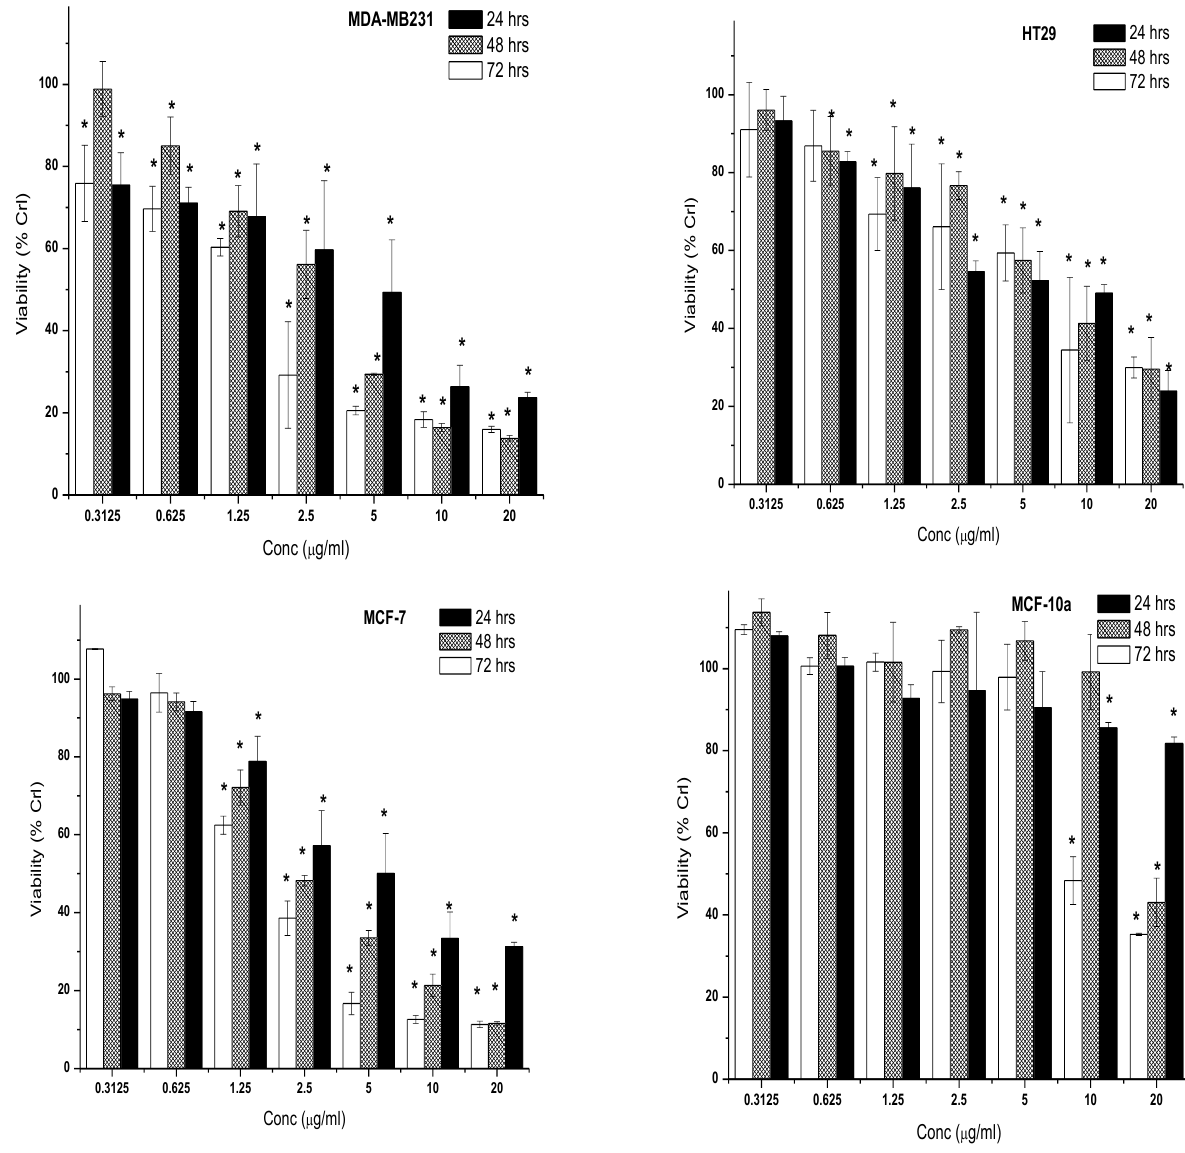
Figure 8. Cytotoxic effect of the 7-geranyloxycinnamic acid on cancer cell lines (MDA MB 231, HT29, MCF-7) and normal cell line (MCF-10a). Cells were incubated with increasing concentrations of the compound in DMEM culture media for 24, 48, and 72 h. Results are expressed as the mean ± SD of three replicates in three independent experiments. * Asterisk indicates significant difference at p < 0.005.